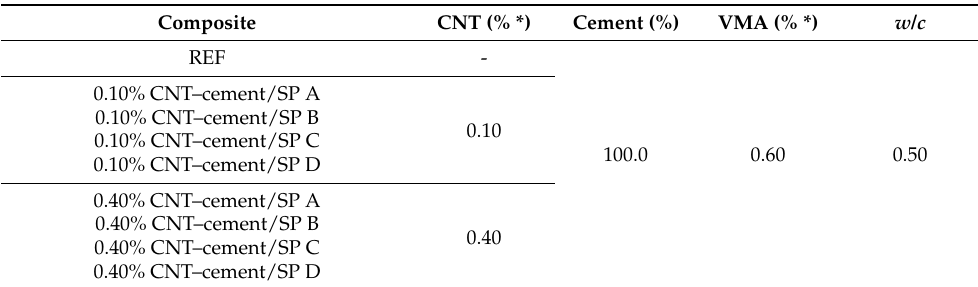
Table 3. CNT–cement composites proportions adopted for electrical resistivity measurements. (* percentage by mass of